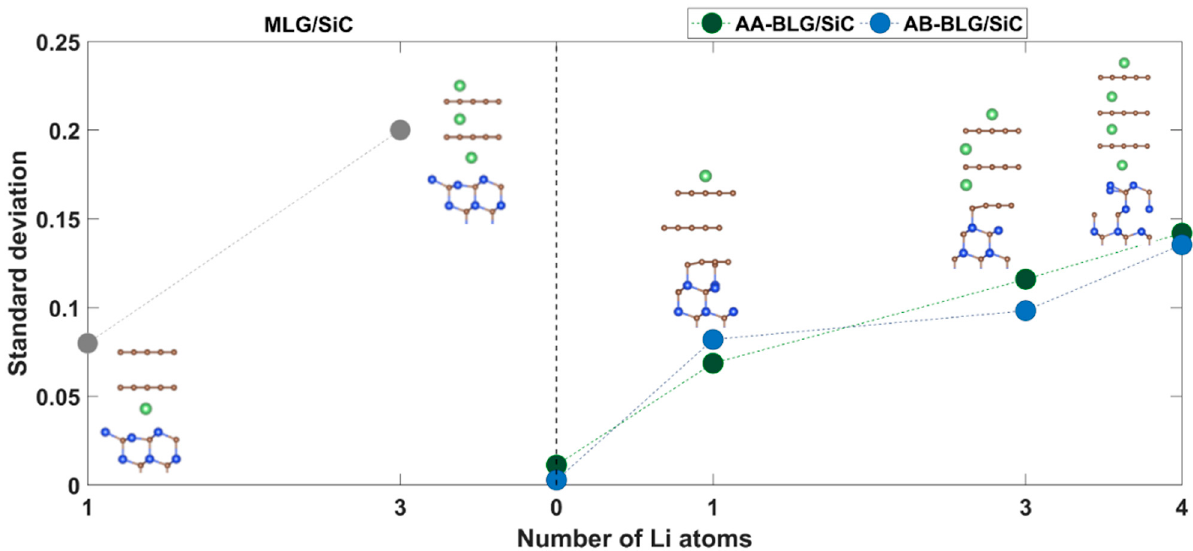
Figure 8. Effect of the number of lithium atoms inserted in epitaxial graphene on the charge redistribution between graphene layers. Here, we initially estimated the total Hirshfeld charge accumulated by a separate graphene layer and then determined the inequivalence of graphene sheets in terms of the standard deviation. The larger the standard deviation, the greater the disparities between graphene layers. The images inside the figure correspond to the optimized structures of different lithiated electrodes. For the sake of simplicity, we demonstrate only a few topmost Si-C bilayers. The comparison of the 2 D vs. G peak dependencies before and after lithiation reveals